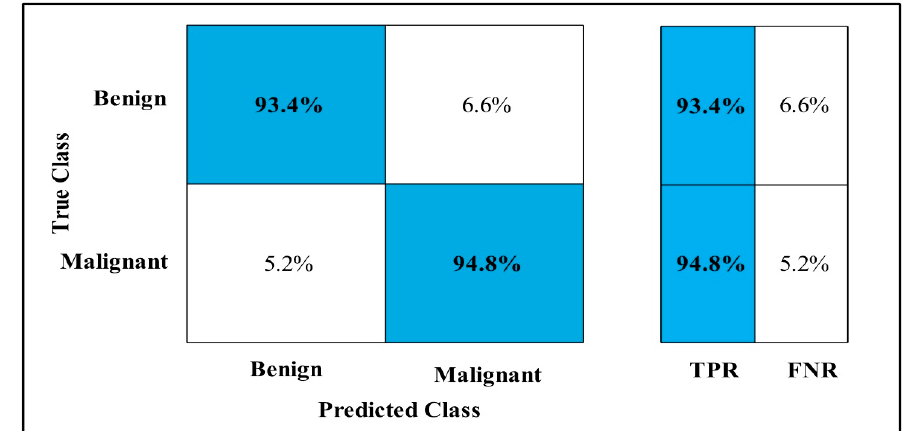
Figure 11. Fusion on MobilenetV2 and Nasnet TPR for CBIS-DDSM. In Table 7, MEWOA on fusion is applied to the CBIS-DDSM dataset. The deep fea- tures of the dataset are extracted from the GAP layer and fed to classifiers.